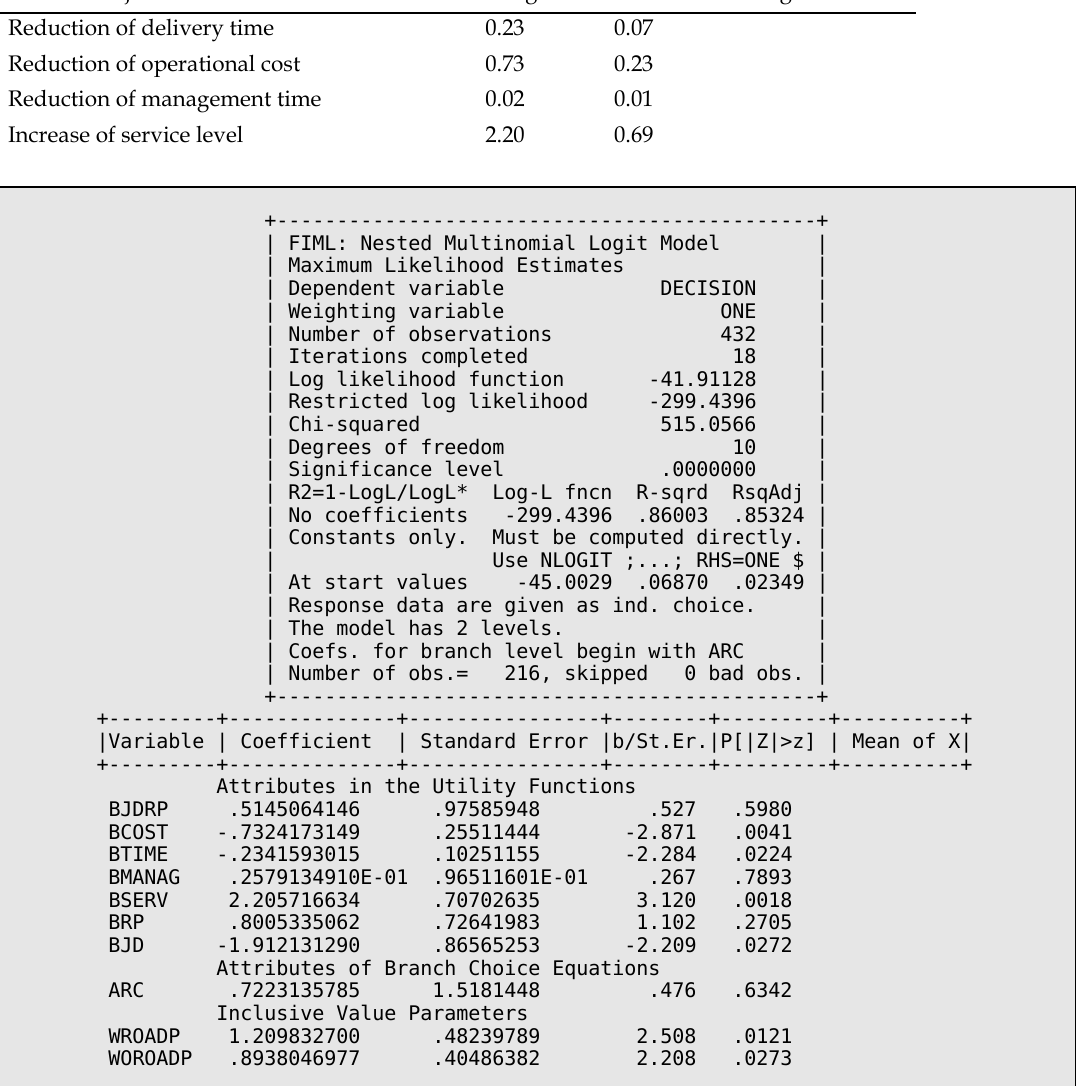
Figure 3. Output report provided by Limdep® for the nested logit